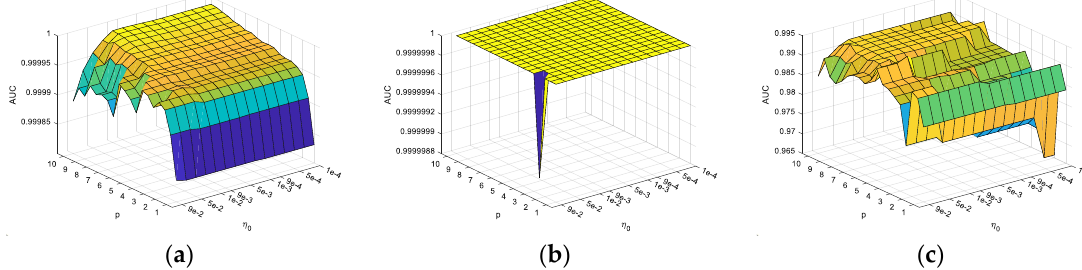
Figure 18. The effect of parameter p and stopping criterion η 0 on the experimental results in the ADHBS method for the three datasets. ( a ) The effect on the San Diego airport data. ( b ) The effect on the Indian Pines data. ( c ) The effect on the Okavango Delta data.